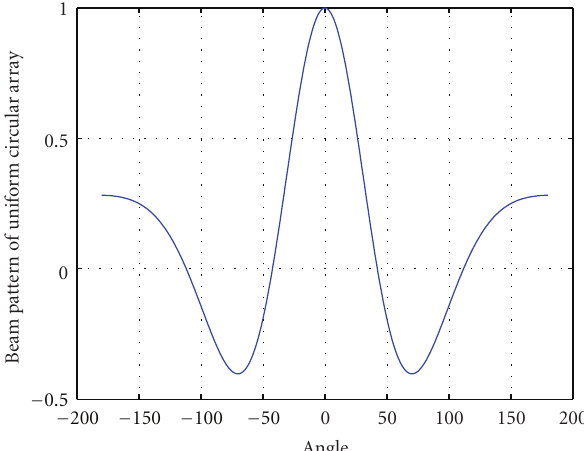
Figure 2: Beam pattern of the uniform circular array ( M = 10, d cir /λ = 1 / 3, ϕ 0 =